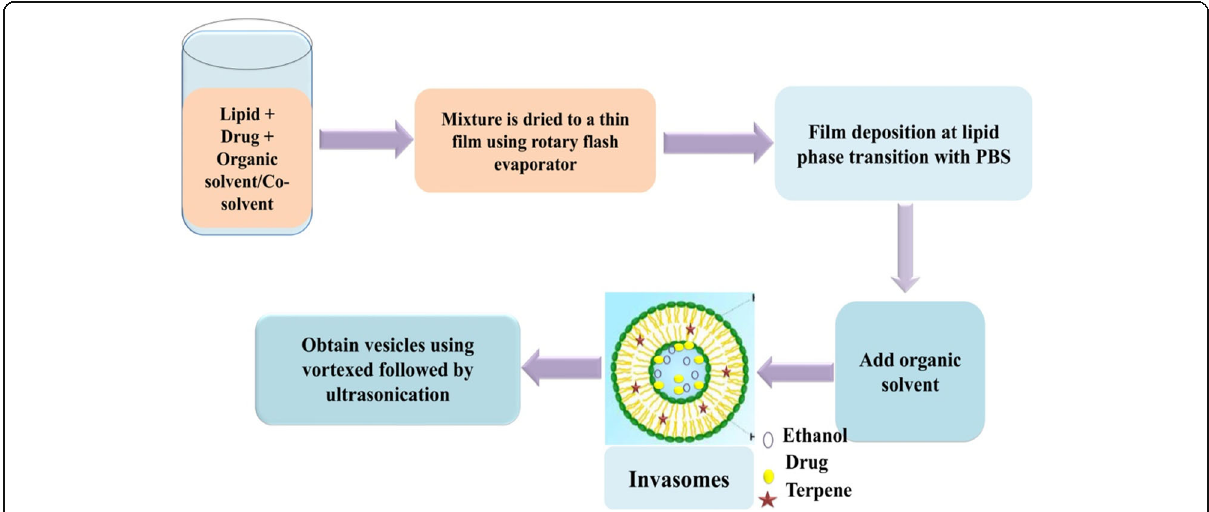
Fig. 4 Preparation of invasomes using film hydration